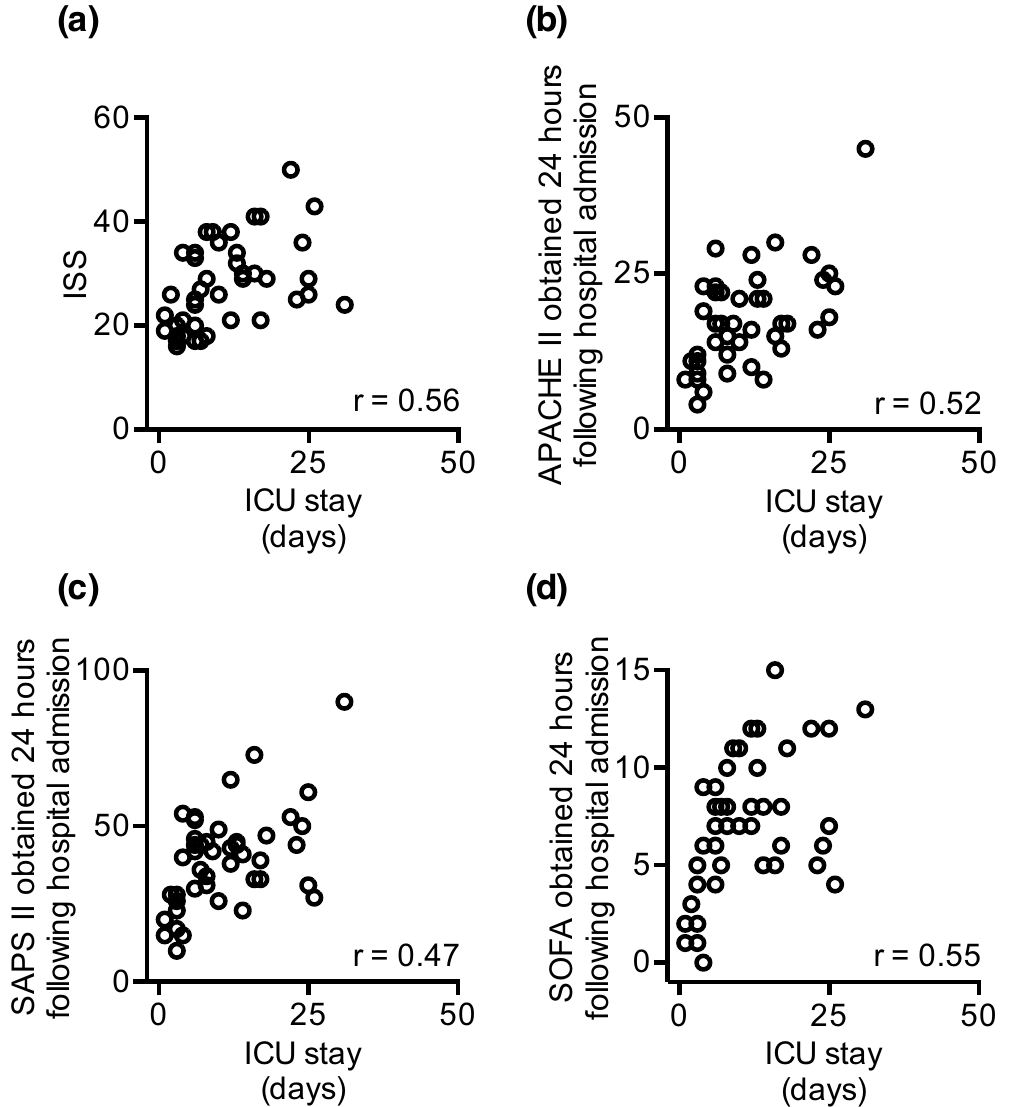
Figure 3. Disease severity scores correlate with the length of ICU stay following major traumatic injury (MTI). ( a ) The obtained ISS score correlates with the length of the ICU stay of severely injured patients. (b) APACHE II, (c) SAPS II and (d) SOFA scores obtained 24 hours after the hospital admission following MTI correlate with the length of ICU stay. r – Spearman correlation coefficient; ICU – intensive care unit; ISS – injury severity score; APACHE II - Acute Physiology And Chronic Health Evaluation II; SAPS II - Simplified Acute Physiology Score; SOFA - Sequential Organ Failure